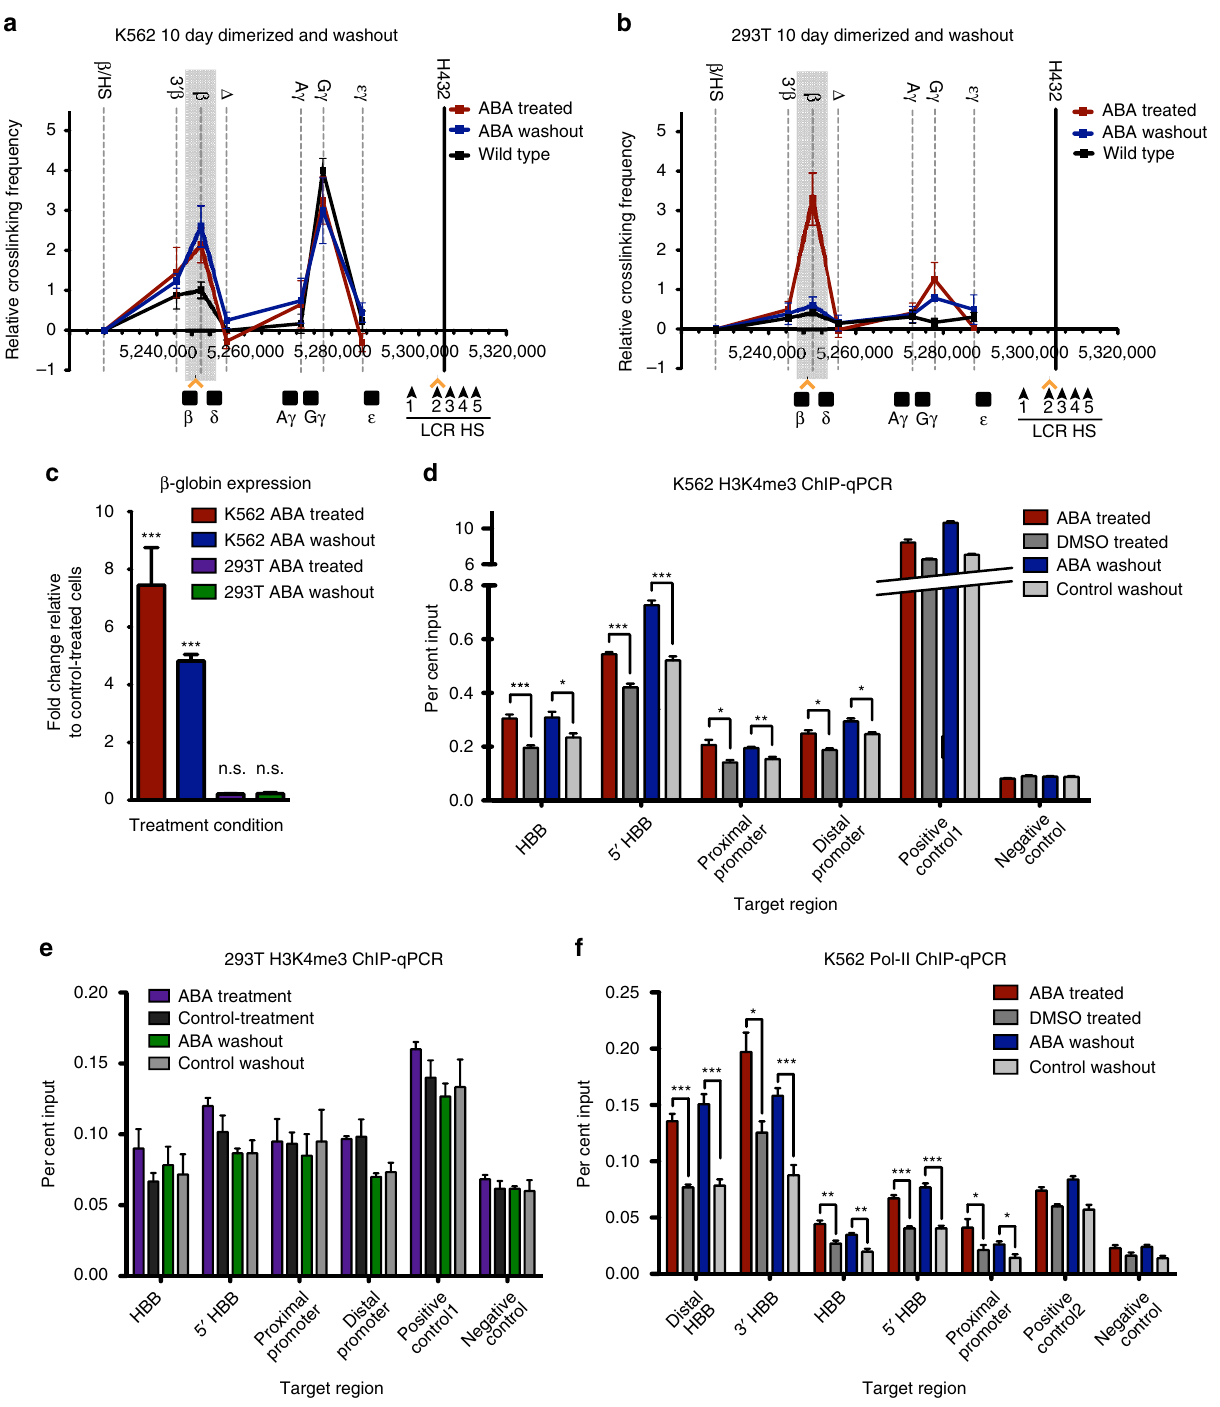
Figure 3 | CLOuD9 establishes stable chromatin loops that sustain robust gene expression following long-term dimerization. ( a , b ) 3C assay demonstrates that in K562s but not 293Ts, CLOuD9-induced chromatin looping becomes irreversible after 10 days of ABA treatment, even when ABA is removed for up to 10 additional days. All 3C results were obtained from at least three independent experiments. 3C values were normalized to tubulin, and interaction frequencies between the anchor fragment and the fragment encompassing the b /HS fragment were set to zero. Error bars indicate s.d. n ¼ 3. ( c ) Loop stabilization in K562s results in persistent expression of b -globin, even following 10 days of ABA washout. No changes in b -globin expression are observed in 293Ts. Significance given relative to control treated cells. Two-tailed student’s t- tests *** P o 0.0001, t ¼ 5.963, df ¼ 5; n.s. non-significant ( d ) ChIP-qPCR showing increases in H3K4me3 marks over the b -globin locus in response to CLOuD9-induced looping are sustained following 10 days of ligand washout in K562s. Two-tailed student’s t- tests * P o 0.05, ** P o 0.001, *** P o 0.0001. ( e ) No significant alterations in H3K4me3 signals following long-term dimerization were observed by ChIP-qPCR in 293Ts. ( f ) Increased RNA Pol-II occupancy of the b -globin locus following long-term loop induction was maintained in K562s following 10 days of ligand washout. Two-tailed student’s t- tests * P o 0.05, ** P o 0.001, *** P o 0.0001. All error bars indicate